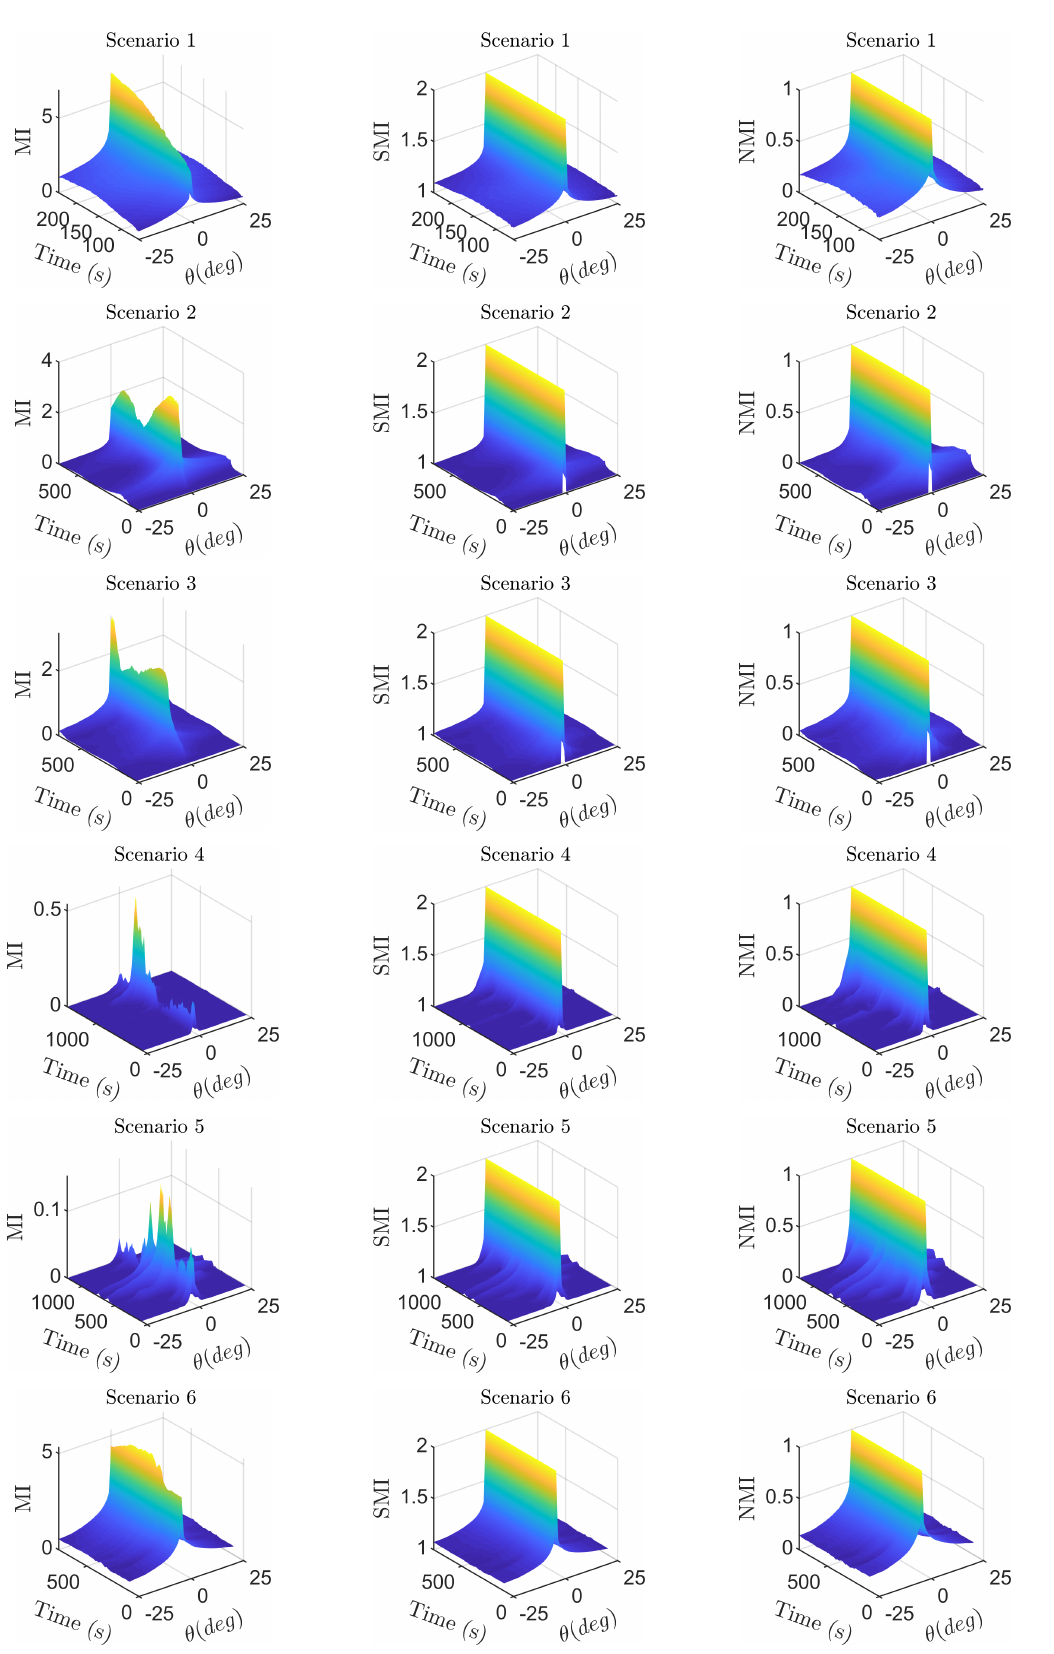
Figure 7. 3D representation of MI-based metrics response to time and image rotation under idealized conditions. Analogous results for translations and scaling are included in Supplementary